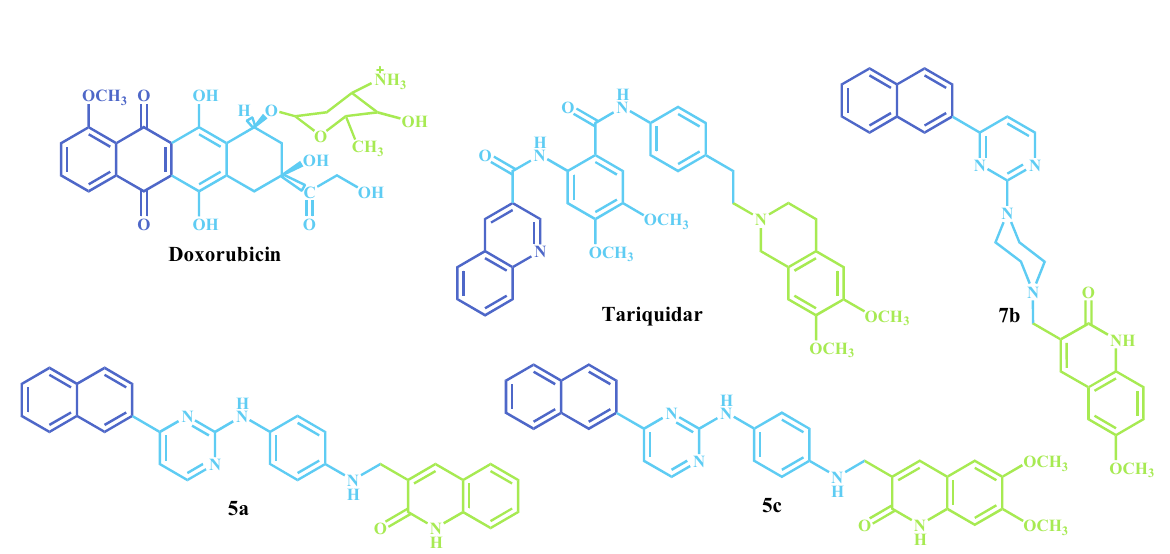
Figure 9. Sum of charge density values (atomic units) at the critical intermolecular binding points between P-gp and ligands with different levels of activity 3 , 5a , 5c , 7b and 8 . Total interactions obtained for the different complexes are shown as a function of the different transmembrane (TMH) domains of the receptor.